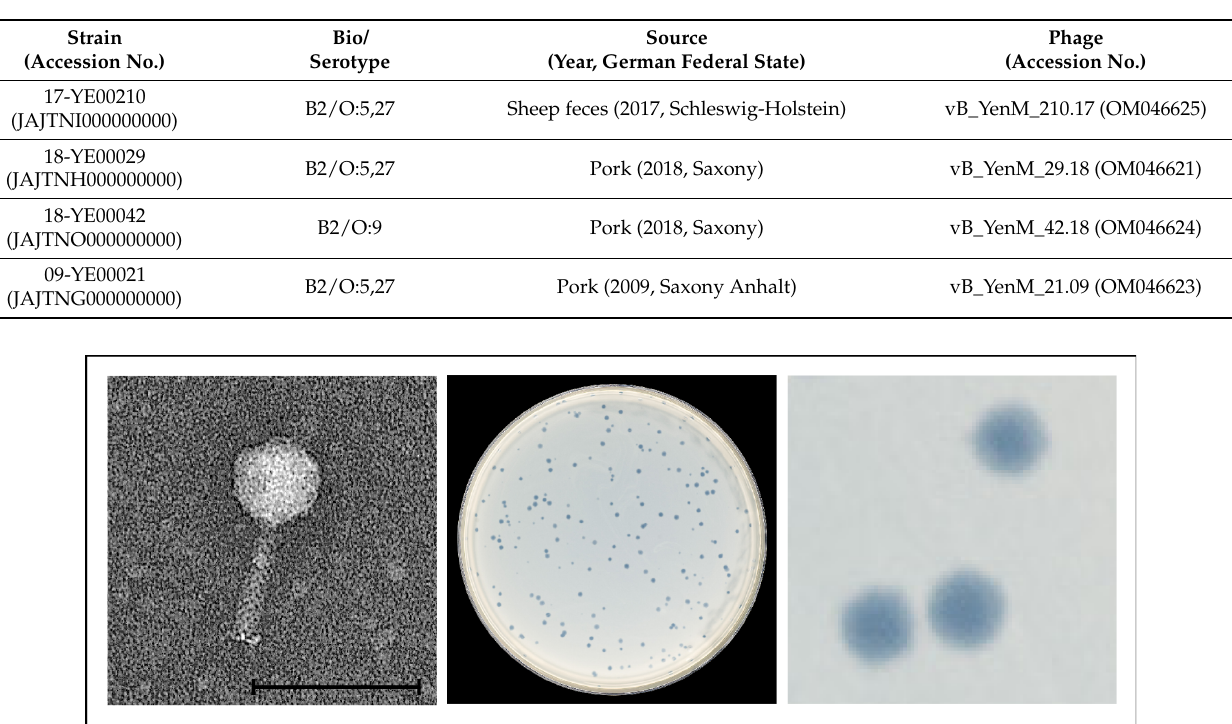
Figure 1. Morphology of and plaques produced by the temperate phage vB_YenM_29.18. The bar represents 100 nm.